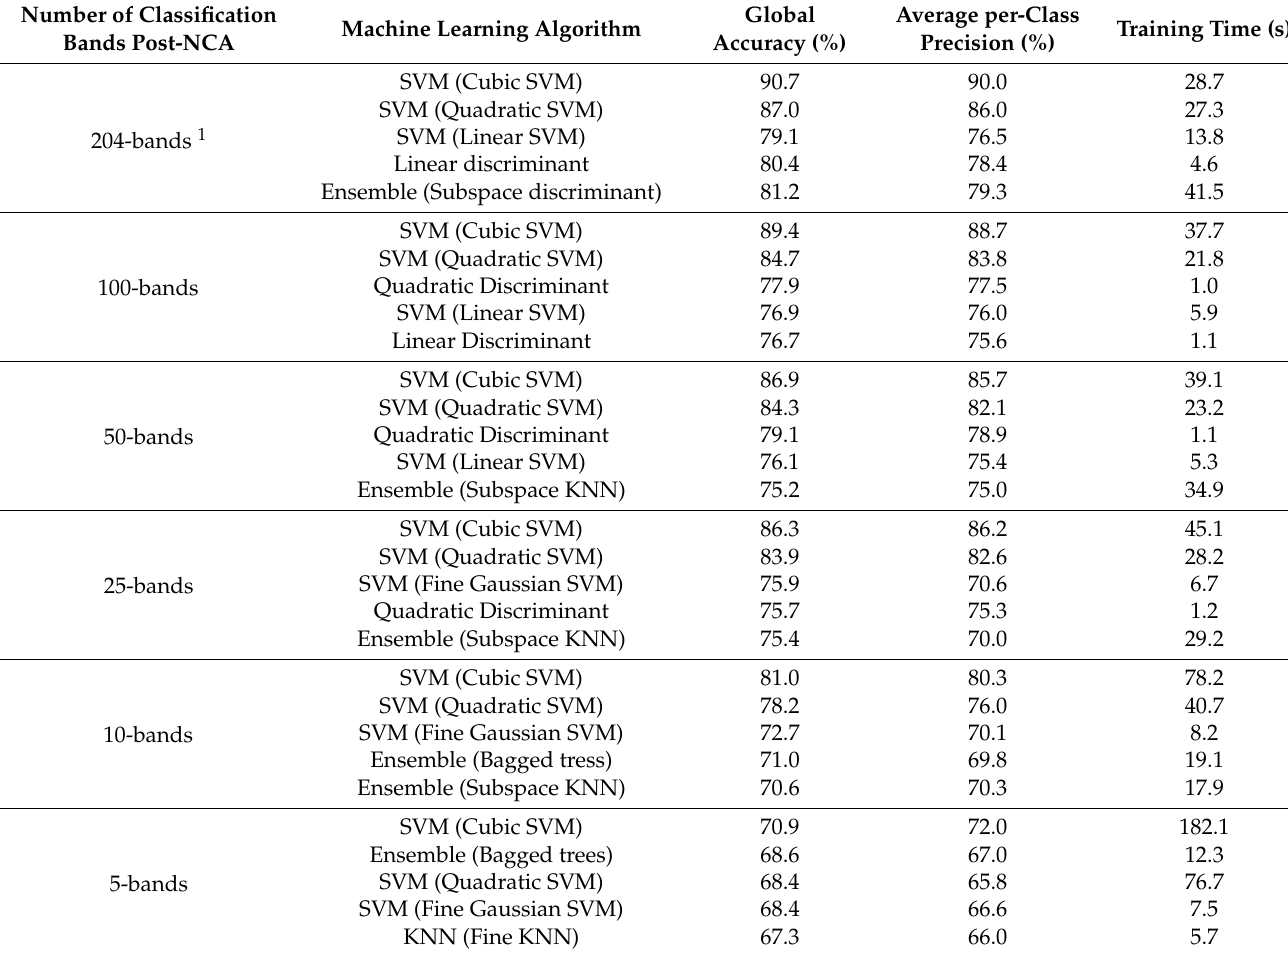
Table 1. Top five machine learning classification comparisons based on predimensionality reduction from 204-bands, to postdimensionality reduction (using Neighbourhood Component Analysis) for 100, 50, 25, 10 and 5 rock spectral bands. Number of